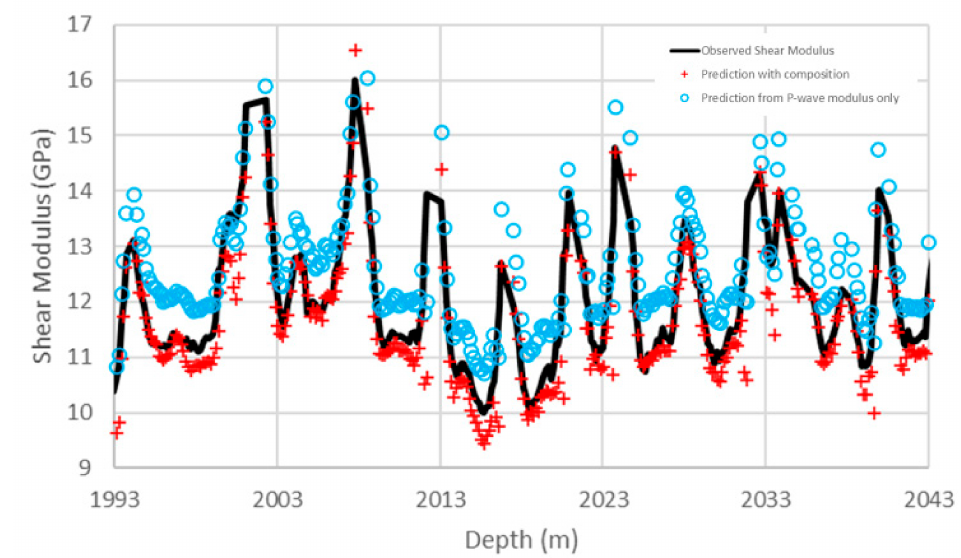
Figure 12. Observed and predicted dynamic shear moduli in an interval of the Spraberry formation. The observed shear modulus log (black line) is straight lined over intervals where logged data were excluded due to high water saturation or low TOC. Predictions are absent in those intervals. The prediction using P-wave modulus alone (open blue circles) with Equation (7) is biased towards higher shear moduli while the prediction with Equation (8) using P-wave modulus and composition (red plus signs) is on average significantly more accurate over this interval. It is significant that the compositional coe ffi cients for Equation (8) were obtained for the entire dataset, including all seven formations, rather than locally calibrated.